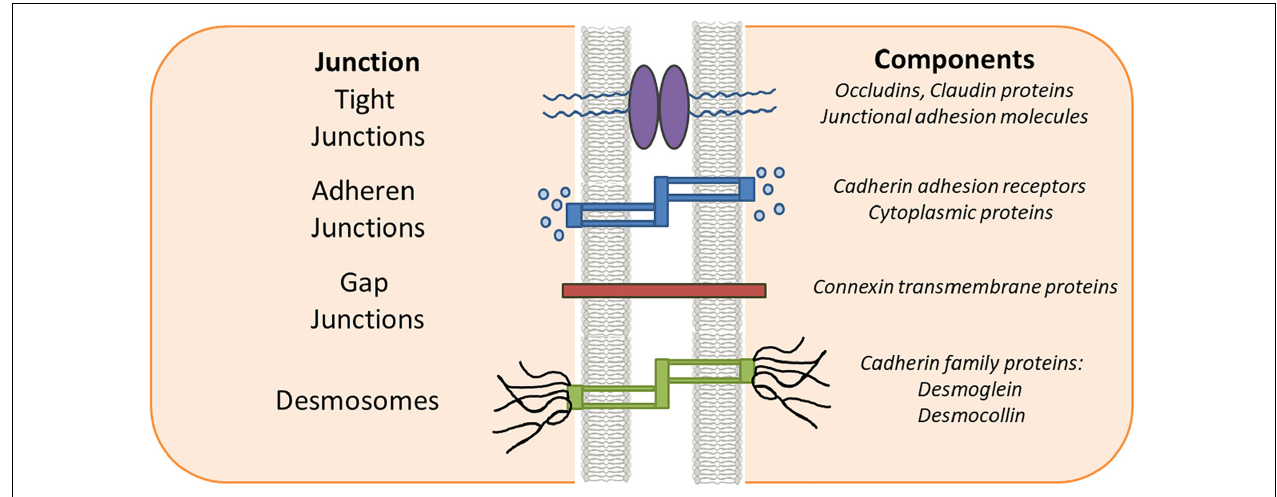
FIGURE 1 | Epithelial intercellular junctions. Schematic drawing of the epithelial junction in vertebrate cell. The tight junctions, adherens junctions and gap junctions are located in the apical most region of the cell while the desmosomes are located toward the basal